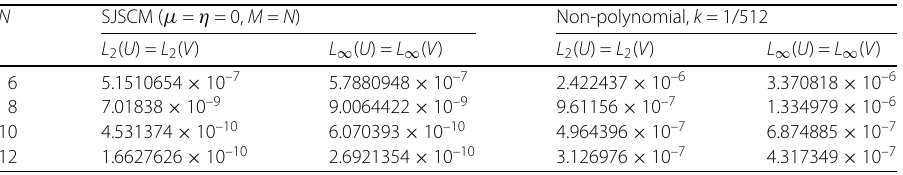
Table 1 L 2 and L ∞ error norms for u ( x , t ) = v ( x , t ) of Example 1 when 0 ≤ x ≤ 1, α 1 = α 2 =